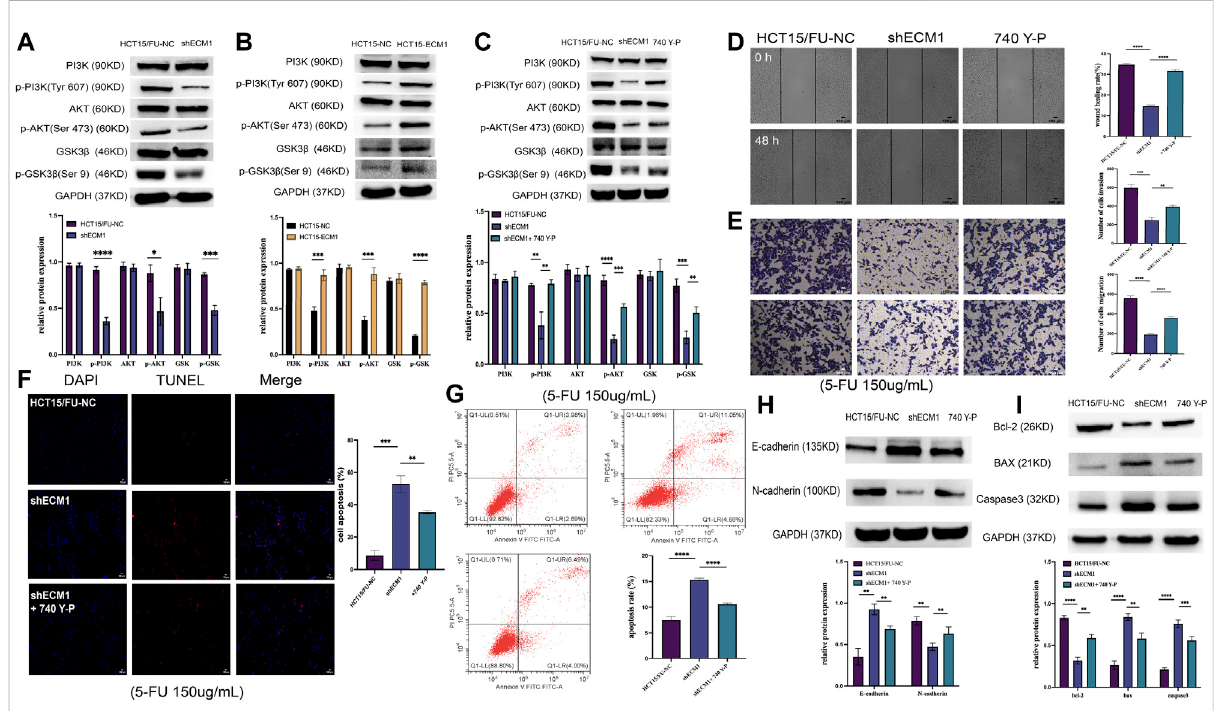
FIGURE 6 ECM1 enhances CRC cell resistance to 5-FU via the PI3K/AKT/GSK3 β pathway. (A,B) The indicated PI3K/AKT pathway proteins and phosphoproteinsweredetectedinHCT15/FUorHCT15cellsinwhichECM1wassilencedoroverexpressed. (C) PI3K/AKT-relatedproteinexpression was detected following 740 Y-P treatment for 24 h to con fi rm treatment ef fi cacy. (D – G) After treatment with 740 Y-P for 24 h, the invasive and migratory activities of HCT15/FU-shECM1 cells were examined via Transwell and wound healing analyses (D,E) . In contrast, their apoptotic death was detected via TUNEL staining and fl ow cytometric analyses (F,G) . (H,I) Western immunoblotting was used to identify proteins involved in apoptosis and EMT. The data are shown as means ± SD (* p < 0.05, ** p < 0.01, *** p < 0.001, **** p <